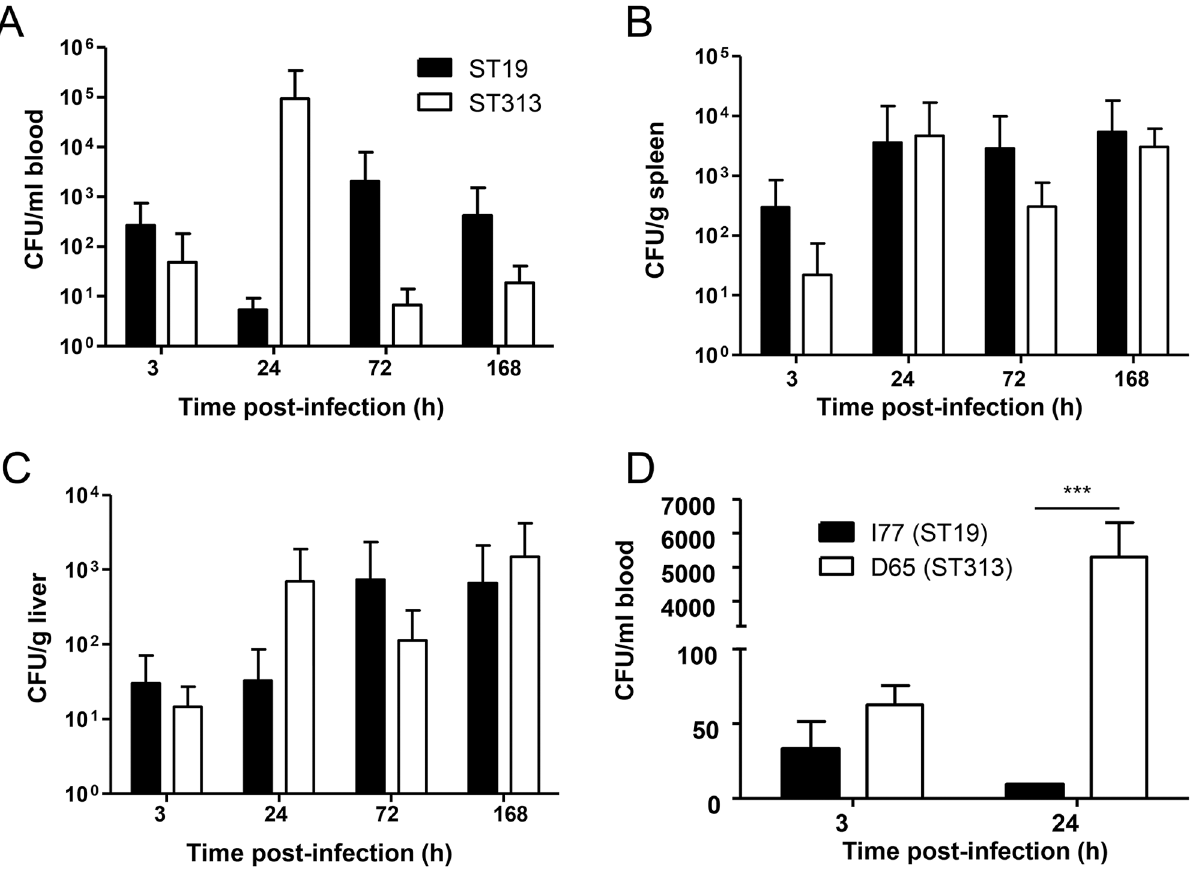
Fig 1. Bacterial load of Salmonella Typhimurium ST313 and ST19 in mice. CD-1 mice were infected perorallywith 3 strains of Salmonella Typhimurium ST19 (I77, I41, S52) and ST313 (D65, Q55, S11). The numberof CFUs at 3, 24, 72 and 168 h p.i. were determined in blood (A), spleen (B) and liver (C). BALB/c mice were infected perorallywith Salmonella Typhimurium I77 and D65 and blood harvestedat 3 and 24 h p.i. (D). Results are expressedas mean ± SD. *** represents P < 0.001, Student’s t-test, two-tailed. https://doi.org/10.1371/journal.pntd.0005697.g001 Table 2. Diarrhea, lethargy and dysenteryelicited by Salmonella Typhimurium I77 (ST19) and D65 (ST313) in Indian rhesus macaques.